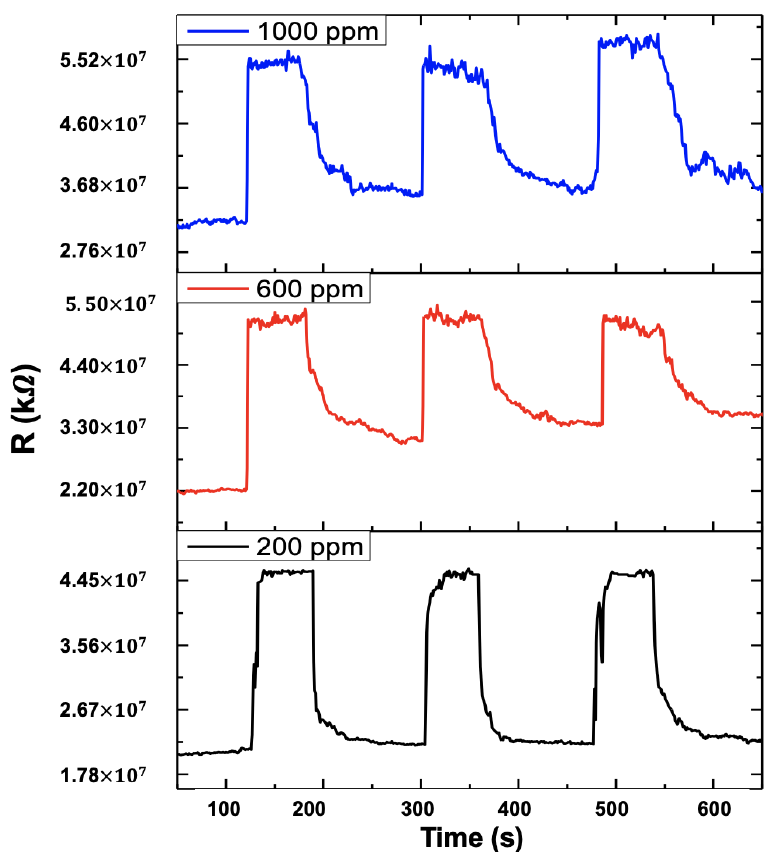
Figure 11. Relative responsiveness of the gCN sensor cyclic exposition to different CO 2 concentrations at 40 °C.